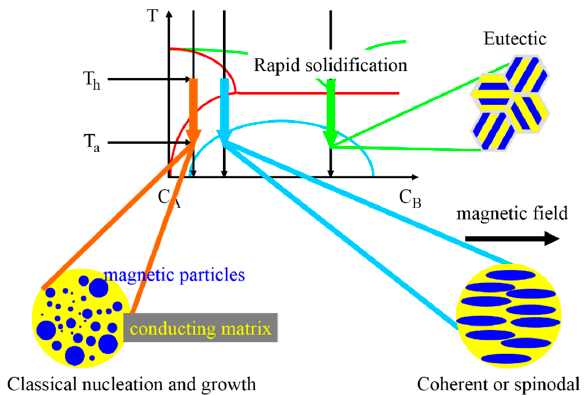
Figure 13. Schematic phase diagram of two metals A (magnetic) and B (non-magnetic) illustrating different types of decomposition which can lead to GMR effects in heterogeneous bulk alloys: (1) classical nucleation and growth of precipitates; (2) coherent or spinodal and (3) eutectic decomposition, which forms a lamellar microstructure similar to